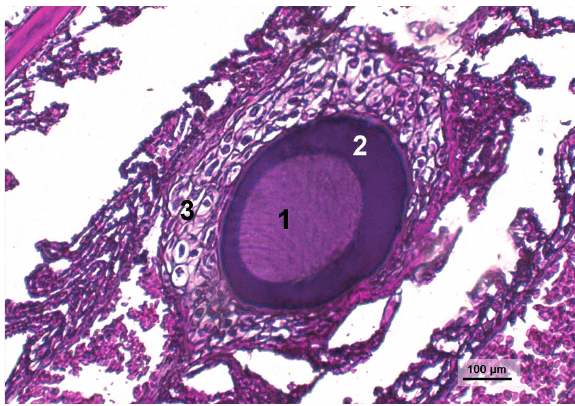
Fig . 2. – Cyst of unknown etiology in the gills of Mullus barbatus . 1, eosinophilic central core; 2, basophilic material; 3, inflammatory response.